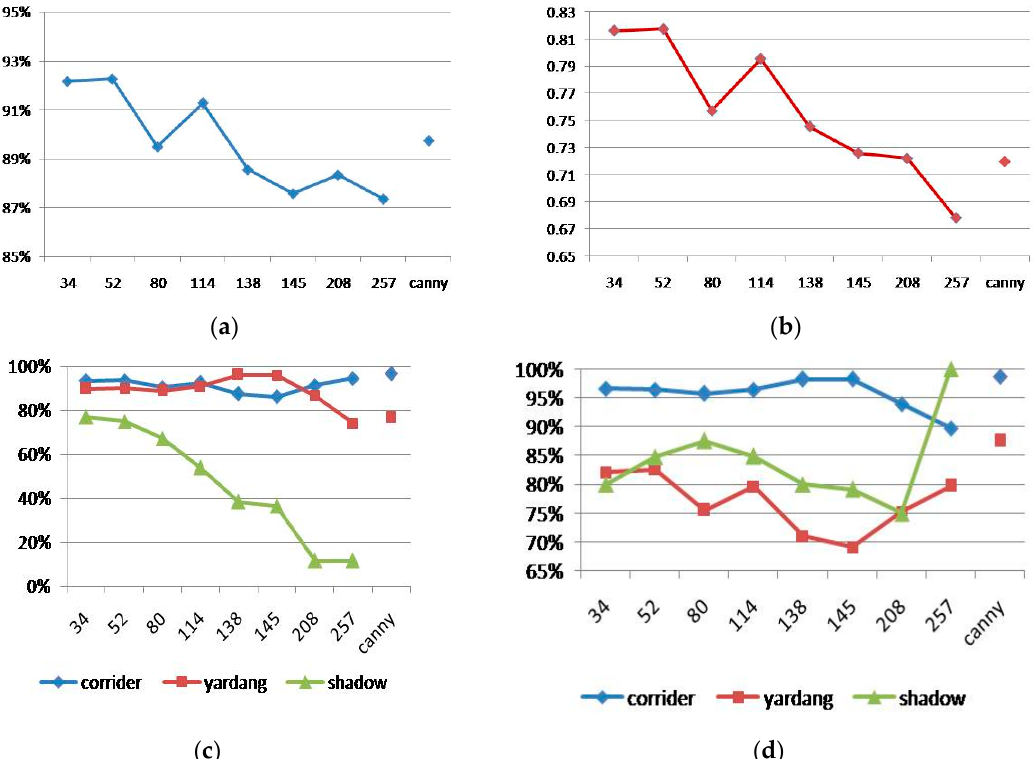
Figure 5. Accuracy curves with different segmentation scales and Canny edge detection: ( a ) OA, ( b ) Kappa, ( c ) PA, and ( d ) UA.